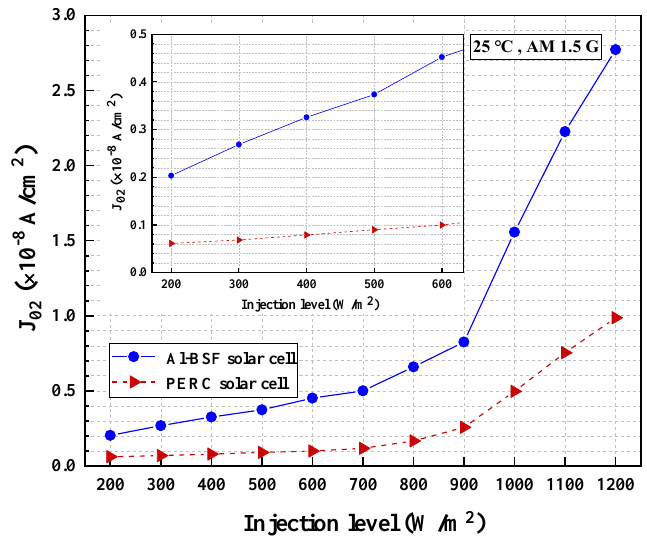
Figure 6. J 02 of an Al-BSF solar cell and a PERC solar cell as a function of the injection level at 25 °C and AM1.5G.